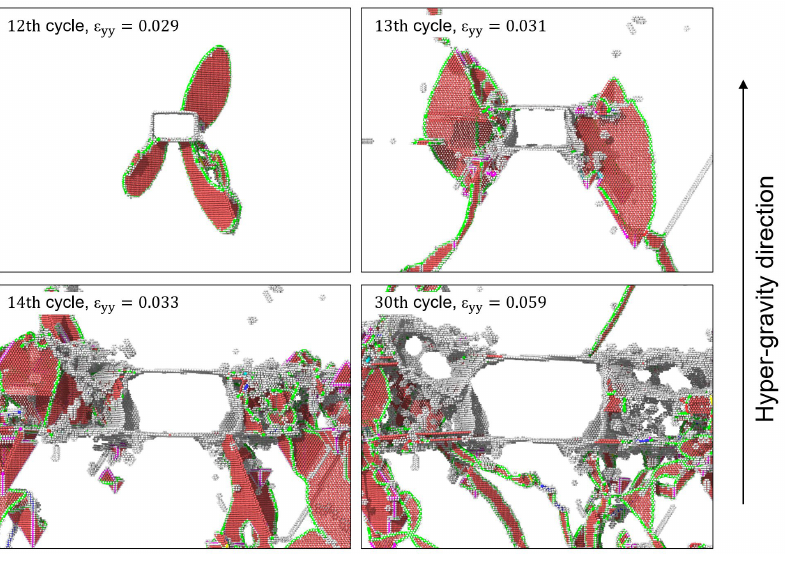
Figure 13. The microstructure evolution of [11 − 2](111) crack at 300 K and zero-gravity. At the hyper-gravity of 1 × 10 12 g, 3 × 10 12 g, and 6 × 10 12 g, the cracks start to emit the slip bands from the crack tip at cycle 9, cycle 7, and cycle 3, respectively. The two tips of the high-stress area are first emitted from the slip zone; this is due to the gradient stress created by hyper-gravity. Figure 14 shows the microstructure evolution of [11 − 2](111) crack at 300 K and 1 × 10 12 g. In cycle 9, plastic deformation was observed at the crack tip, and the direction of the slip bands is identical to the zero-gravity condition, indicating that the addition of gravity does not change the direction of slip but advances the time of crack propagation.